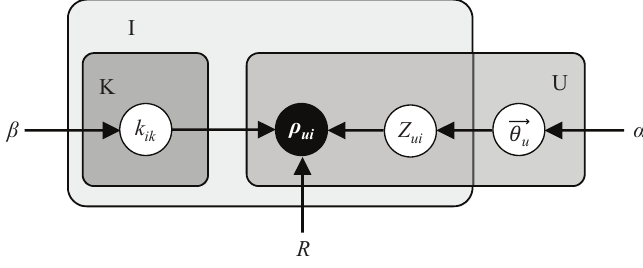
Figure 2. Graphical representation of BNMF model.